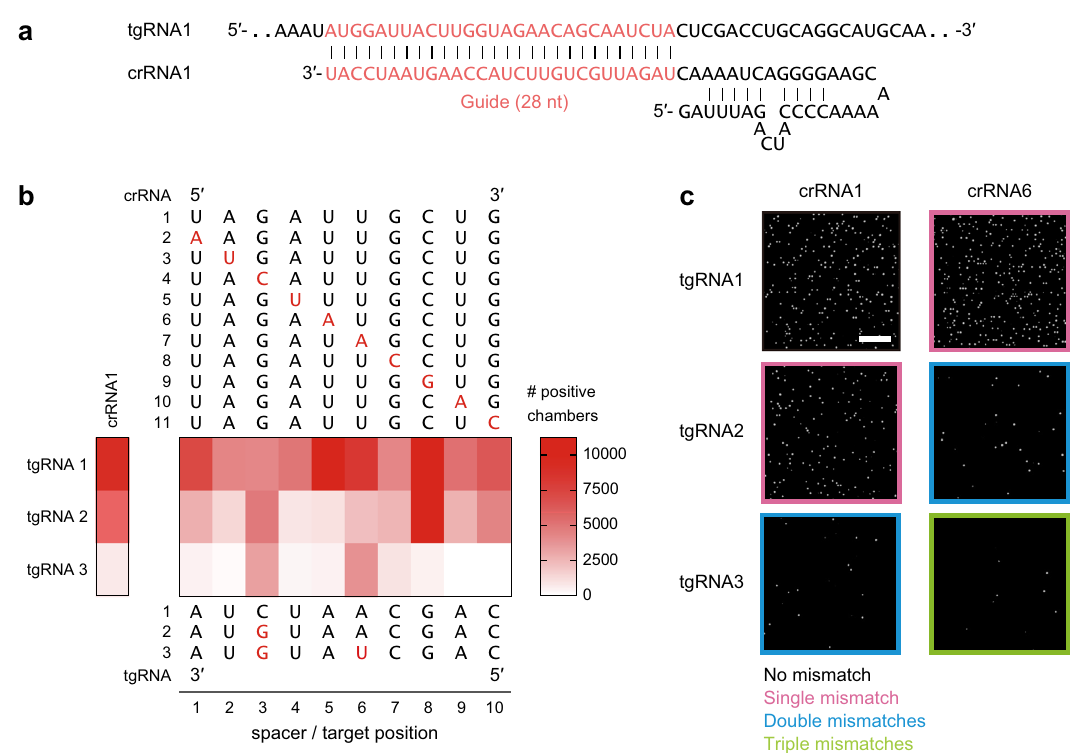
Fig. 2 Sequence speci fi city of SATORI. a Sequences of the crRNA and tgRNA. b Effects of single, double, and triple mismatches on the number of positive chambers. Mutations are highlighted in red. Data are means ( n = 3 technical replicates). c Representative fl uorescence images obtained with different combinations of the crRNA and tgRNA